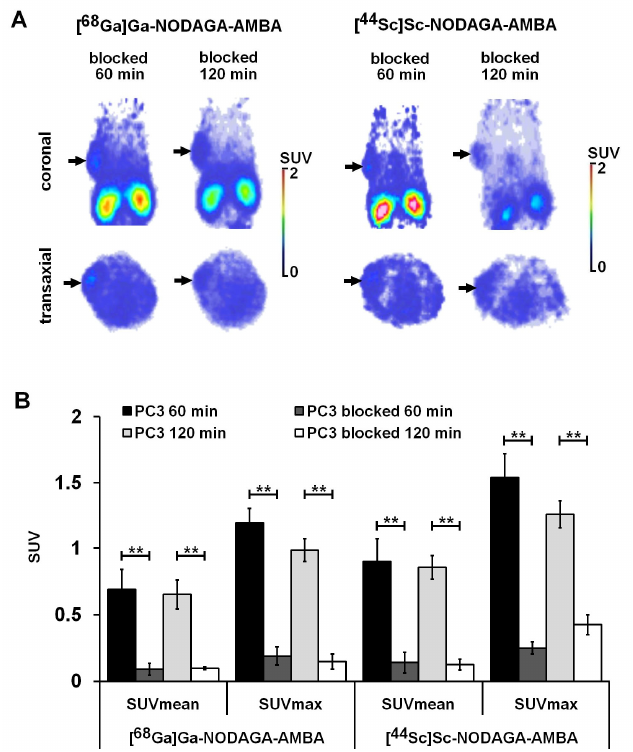
Figure 5. In ‐ vivo PET imaging and quantitative image analysis of subcutaneous PC ‐ 3 using [ 68 Ga]Ga ‐ Figure 5. In-vivo PET imaging and quantitative image analysis of subcutaneous PC-3 using [ 68 Ga]Ga- NODAGA ‐ AMBA and [ 44 Sc]Sc ‐ NODAGA ‐ AMBA radiotracers. ( A ) Representative coronal (upper NODAGA-AMBA and [ 44 Sc]Sc-NODAGA-AMBA radiotracers. ( A ) Representative coronal row) and transaxial (lower row) PET images of blocked (15 mg/kg bombesin) GRPR ‐ positive PC ‐ 3 tumors. ( B ) Quantitative SUV analysis of [ 68 Ga]Ga ‐ NODAGA ‐ AMBA and [ 44 Sc]Sc ‐ NODAGA ‐ AMBA accumulation in blocked PC ‐ 3 tumors (n = 5 animals/radiotracer/time point). Decay ‐ corrected PET im ‐ ages and data were obtained 14 ± 1 days after tumor cell inoculation and 60 and 120 min after intrave ‐ nous injection of the radiotracers. Black arrows: blocked PC3 tumors. Significance level: p ≤ 0.01 (**). T/M: tumor ‐ to ‐ muscle ratio. SUV values are presented as mean ± SD. Table 1. Ex ‐ vivo assessment of [ 68 Ga]Ga ‐ NODAGA ‐ AMBA and [ 44 Sc]Sc ‐ NODAGA ‐ AMBA accumu ‐ lation (%ID/g) in PC ‐ 3 experimental tumors 60 and 120 min after intravenous tracer injection and 14 ± 1 days after tumor induction. Significance level between non ‐ blocked and blocked tumors: p ≤ 0.01 (**); 15 mg/kg BBN was used for blocking. T/M: tumor ‐ to ‐ muscle ratio. Tumor